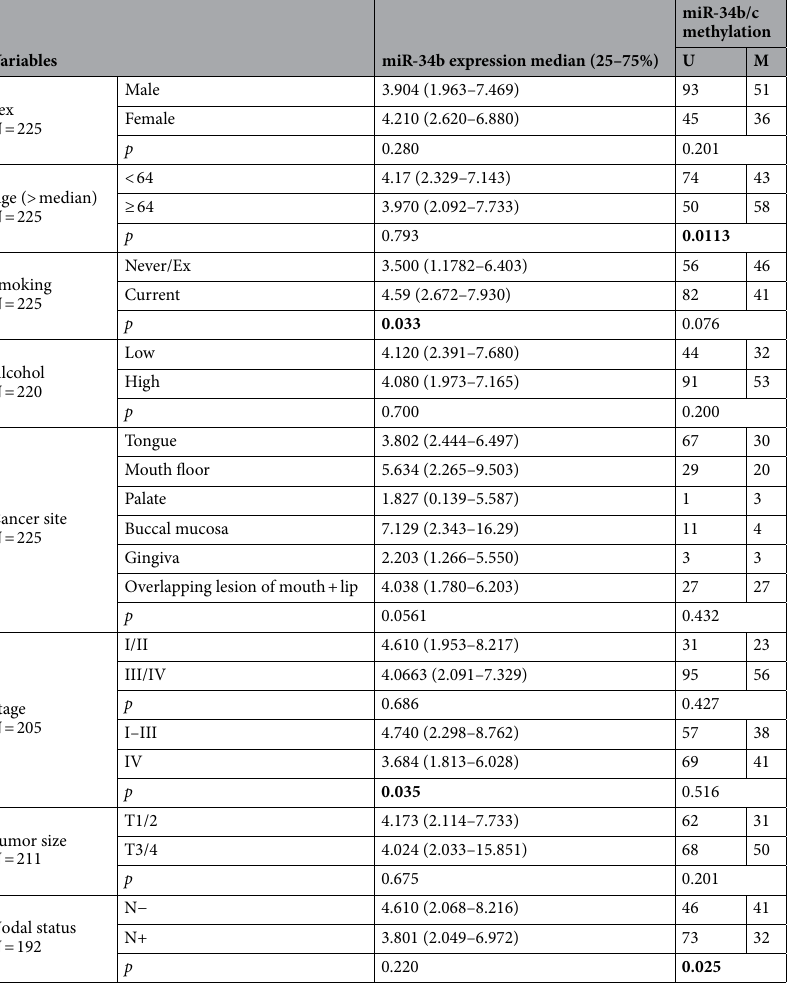
Table 3. The association of miR-34b/c promoter methylation, and miR-34b gene expression with demographic and clinico-pathohistological features of validation TCGA cohort. Significant values are in bold. U Unmethylated, M Methylated. Mann–Whitney U test was used for comparison expression data with clinico- pathohistological